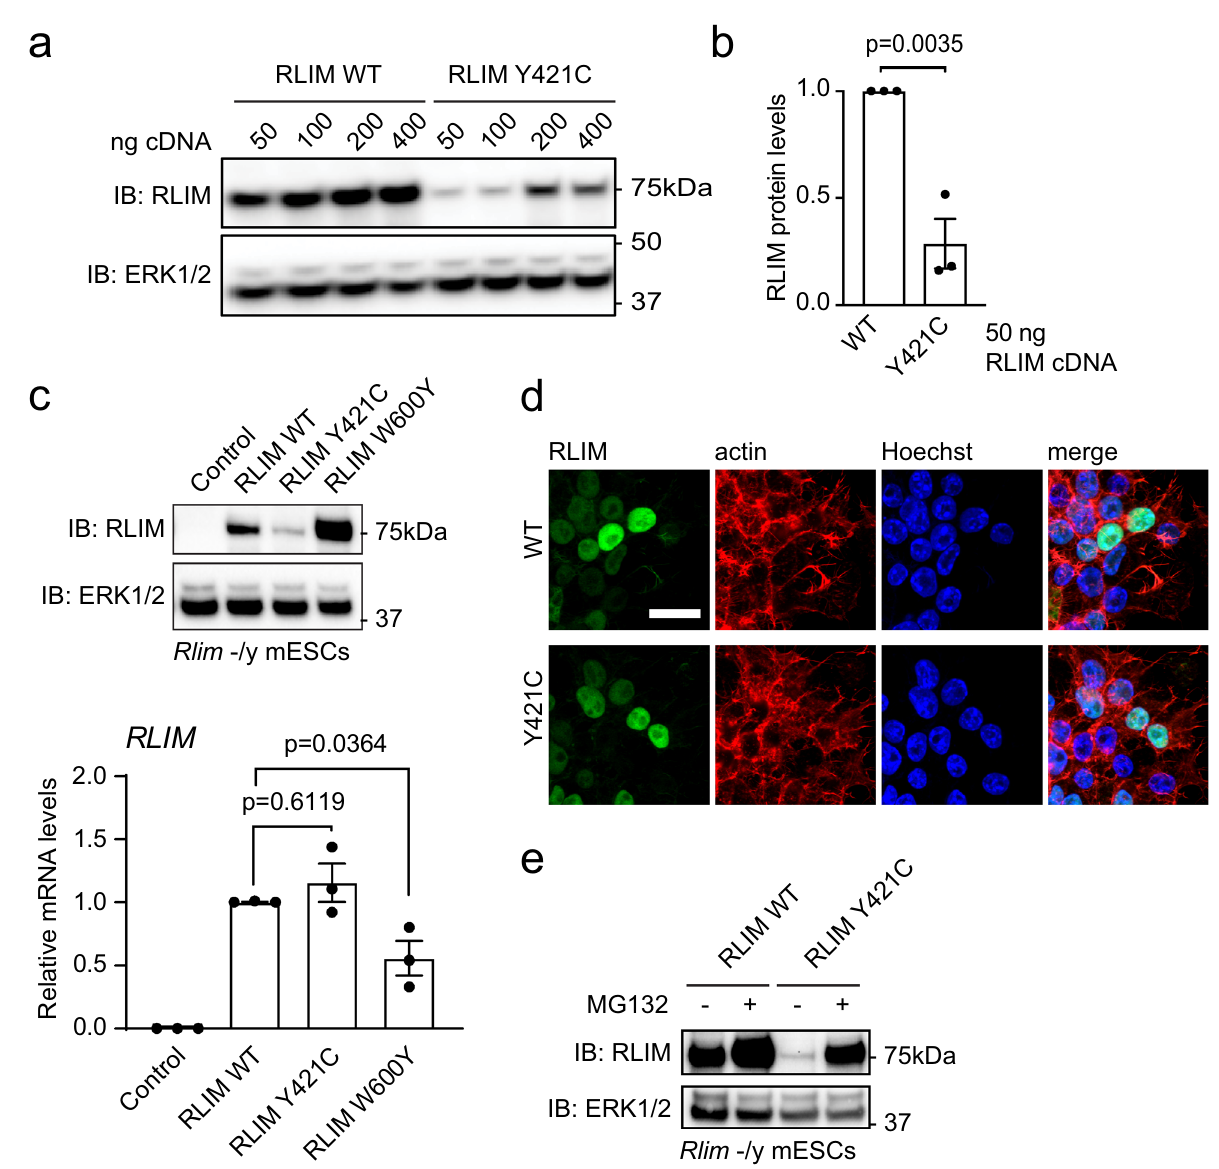
Figure 2. RLIM p.(Tyr421Cys) is poorly expressed and readily degraded by the proteasome. ( a ) Human RLIM wild-type (WT) or Y421C TOKAS variant were expressed at increasing amounts (50–400 ng plasmid DNA) in Rlim -/y mESCs. RLIM expression was determined by immunoblotting and ERK1/2 expression analysed as a loading control. ( b ) Quantification of human RLIM wild-type (WT) or Y421C TOKAS variant protein expression from 50 ng plasmid cDNA in Rlim -/y mESCs. RLIM expression was determined by immunoblotting. Normalised data are represented as mean ± standard error of the mean (n = 3). Statistical significance was determined by student’s t-test. Figure was generated using BioRad ImageLab v6.0.1 (https:// www. bio- rad. com/ en- uk/ produ ct/ image- lab- softw are? ID= KRE6P 5E8Z) and Graphpad Prism v8.0 (https:// www. graph pad. com/ scien tific- softw are/ prism/). ( c ) Human RLIM wild-type (WT), Y421C TOKAS variant or W600Y catalytically- inactive variant were expressed in Rlim -/y mESCs. (Top panel) Human RLIM protein expression was determined by immunoblotting and ERK1/2 expression analysed as a loading control. (Bottom panel) Human RLIM mRNA expression was determined by qRT-PCR and normalised to Gapdh mRNA expression. Data are represented as mean ± standard error of the mean (n = 3). Statistical significance was determined by one-way ANOVA. Figure was generated using BioRad ImageLab v6.0.1 (https:// www. bio- rad. com/ en- uk/ produ ct/ image- lab- softw are? ID= KRE6P 5E8Z) and Graphpad Prism v8.0 (https:// www. graph pad. com/ scien tific- softw are/ prism/). ( d ) Human RLIM wild-type (WT) and Y421C TOKAS variant were expressed in Rlim -/y mESCs. RLIM localisation was determined by immunofluorescence. Scale Bar = 20 μm. Microscopy images were acquired using Zeiss ZEN 2012 SP5 (black edition) software (https:// www. zeiss. com/ micro scopy/ us/ produ cts/ micro scope- softw are/ zen. html) and processed using NIH Image J v1.48 (https:// imagej. net/) and Adobe Photoshop CC v19.1.8 (https:// www. adobe. com/ uk/ produ cts/ photo shop. html). ( e ) Human RLIM wild-type (WT) or Y421C TOKAS variant were expressed in Rlim -/y mESCs treated with vehicle or 10 μM MG132 for 4 h. RLIM expression was determined by immunoblotting and ERK1/2 expression analysed as a loading